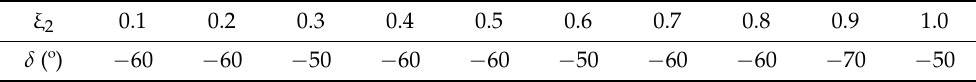
Table 4. Crack initiation angles (degree) calculated using finite element method when ϕ = 30 ◦ .